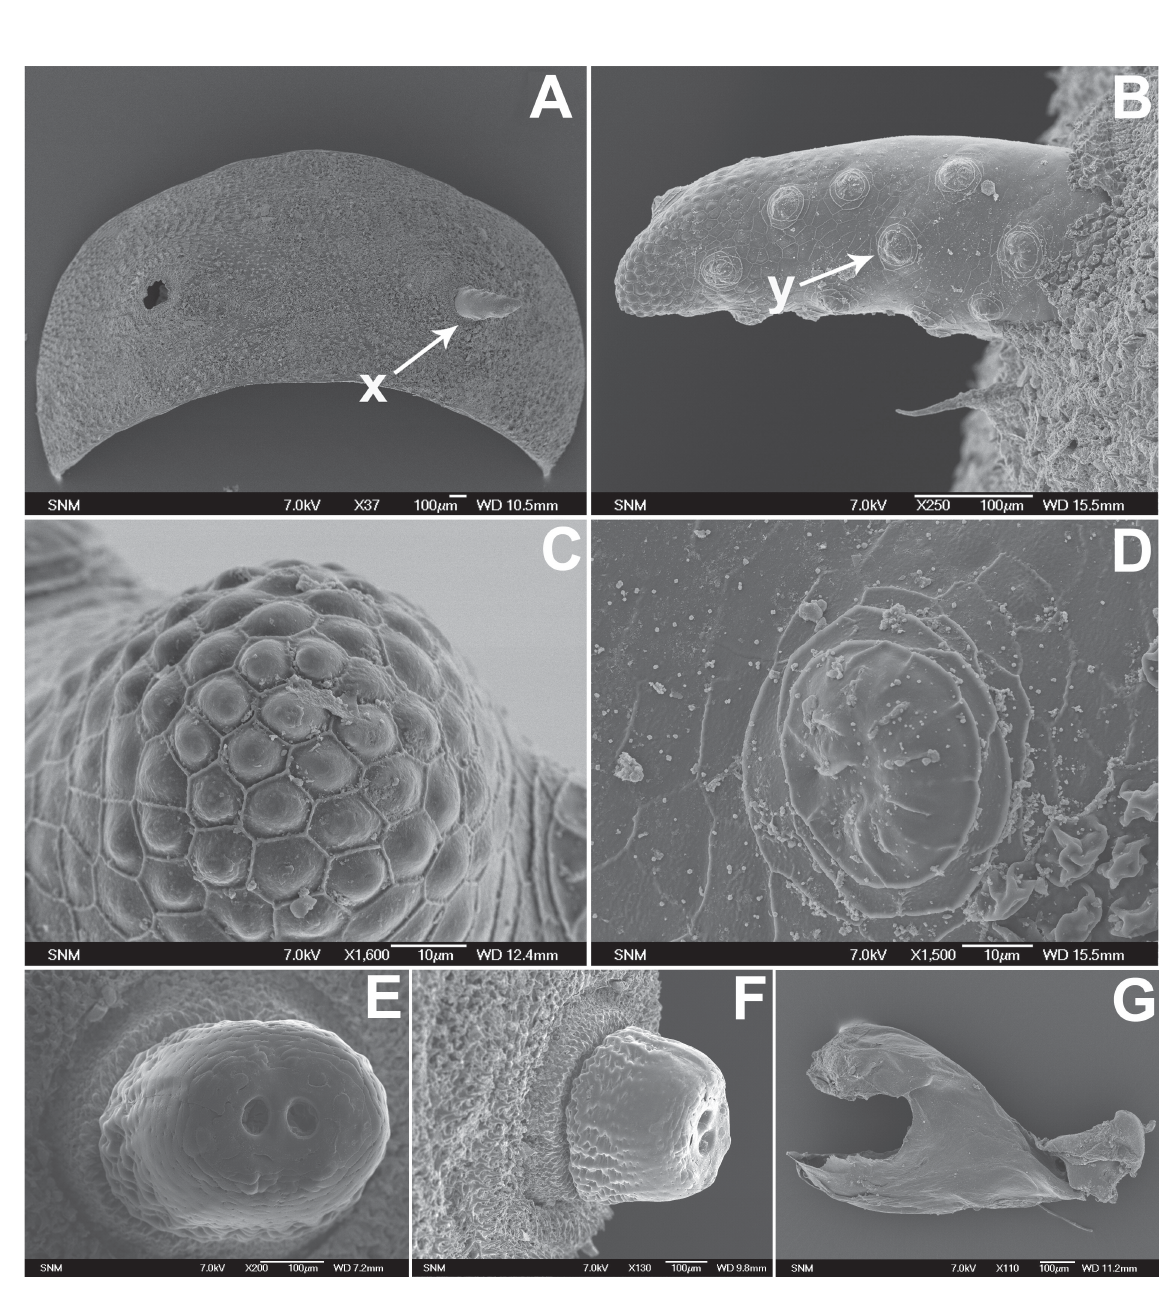
Fig. 14. Megatrigon argenteus (Walker, 1852) comb. nov., puparium (SeM). A . operculum with right pupal spiracle (arrow), B . Pupal spiracle in lateral view (arrow points at tubercle with spiracular openings). C . apex of pupal spiracle. D . detail of tubercle with spiracular openings borne on pupal spiracle. E . Spiracular plate on the posterior respiratory process in polar view. F . Posterior respiratory process. G . Cephaloskeleton, lateral view. Symbols: x = pupal spiracle; y = spiracular